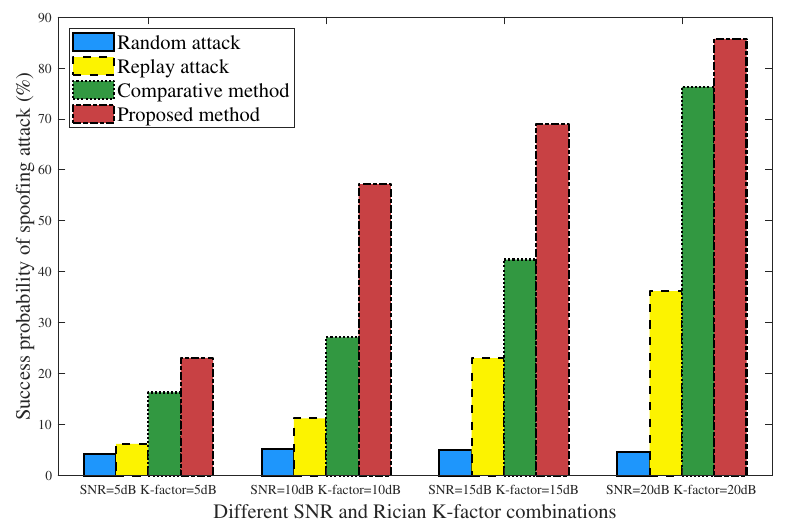
Figure 8. The success probability of spoofing attack versus attack schemes for different channel conditions (different SNRs and Rician K